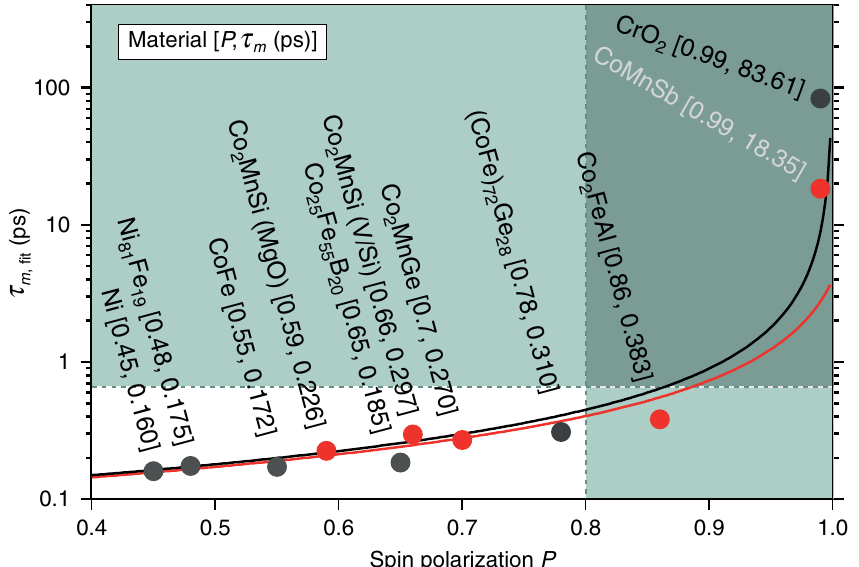
FIG. 3. Demagnetization time (cid:1) m versus spin polarization P . The half-metallic properties can be classified in a P versus (cid:1) m plot. If the points lie on top of the lines given, spin-flip blocking is the dominant mechanism describing the simultaneous increase of P and (cid:1) m . (cid:2) ð 1 (cid:1) P Þ (cid:1) 1 behavior. For each material the The lines are model calculations using Fermi’s golden-rule approach showing the (cid:1) el - sp demagnetization time (cid:1) m taken from Fig. 2 is plotted as a function of the spin polarization P . Note the logarithmic scale for (cid:1) m . (cid:1) ¼ 100 fs and P ¼ 1 , (cid:1) ¼ 3 ps or 1 ns, respectively. Heusler compounds are given in red. In Intersections are P ¼ 0 , (cid:1) m ¼ el ; 0 m c 2 brackets the value of P and (cid:1) m (fs) is